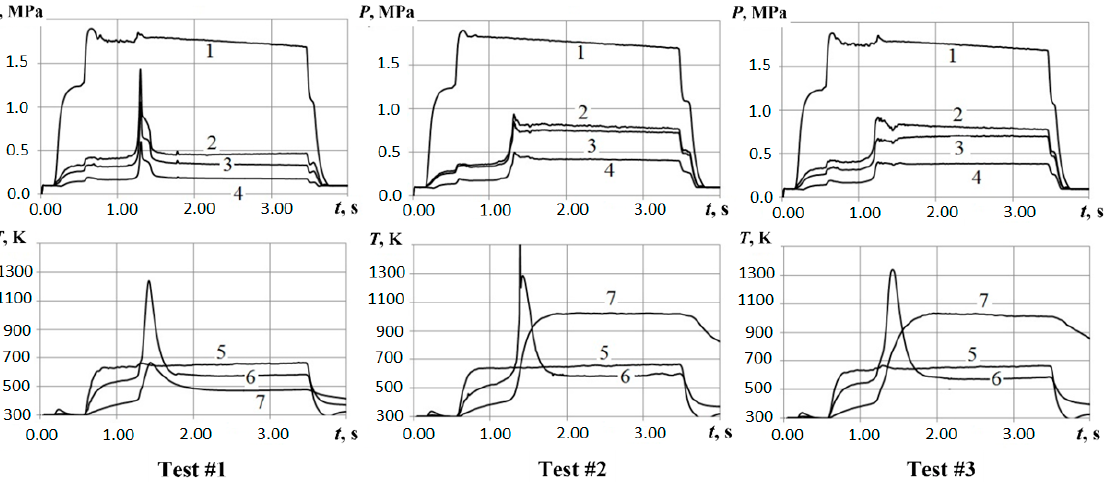
Figure 4. Test results at M 1 = 2.43 (see Table 1): 1— Р 0 ; 2— P 0,in ; 3— P 0,out ; 4— P out ; 5— T 0 ; 6— T 0,in ; 7— T 0,out.